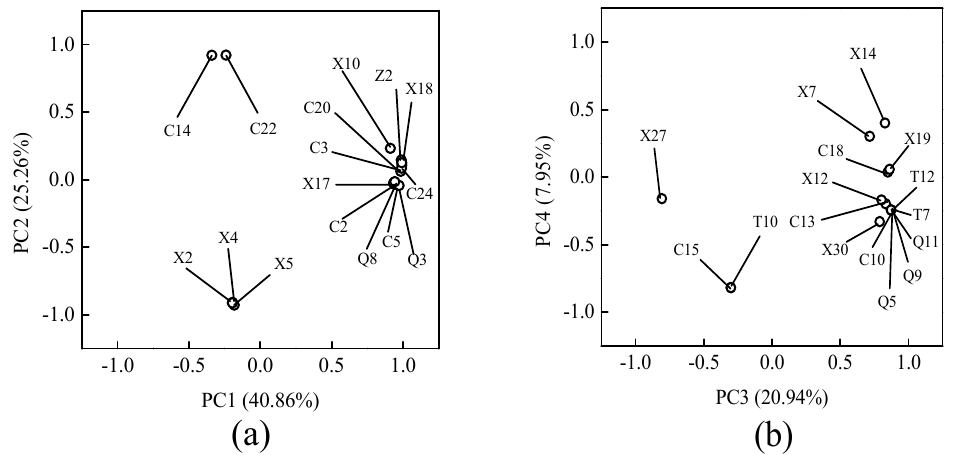
Figure 4. Diagram of principal component (PC) factor of volatile flavor compounds in different treated yacon-litchi-longan (YLL) juice (a) and (b). C2 = 3-Methyl-1-butanol; C3 = 2-Methylbutan-1-ol; C5 = trans-2-Hexen-1-ol; C10 = 1-Octanol; C13 = Bicyclo[3.1.1]hept-3-en-2-ol,4,6,6-trimethyl-; C14 = Neroloxide; C15 = Borneol; C18 = 2-(4-Methylphenyl)propan-2-ol; C20 = 2,6-Dimethyl-3,5,7-